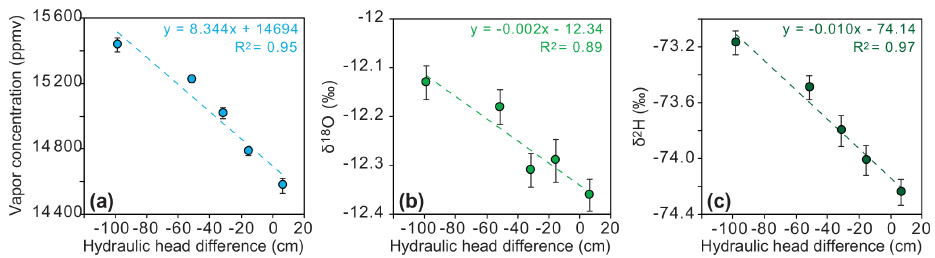
Figure 2. Laboratory experiment showing the isotope effects of sample injection into the Continuous Water Sampler (CWS). Panel (a) shows the measured vapor concentrations, and panels (b) and (c) show the raw, uncalibrated isotope values of a single water sample (nanopure water) as a function of the hydraulic head difference between the water level in the sample bottle and the waste outlet. Negative values of the hydraulic head difference indicate that the sample source was located below the waste outlet of the